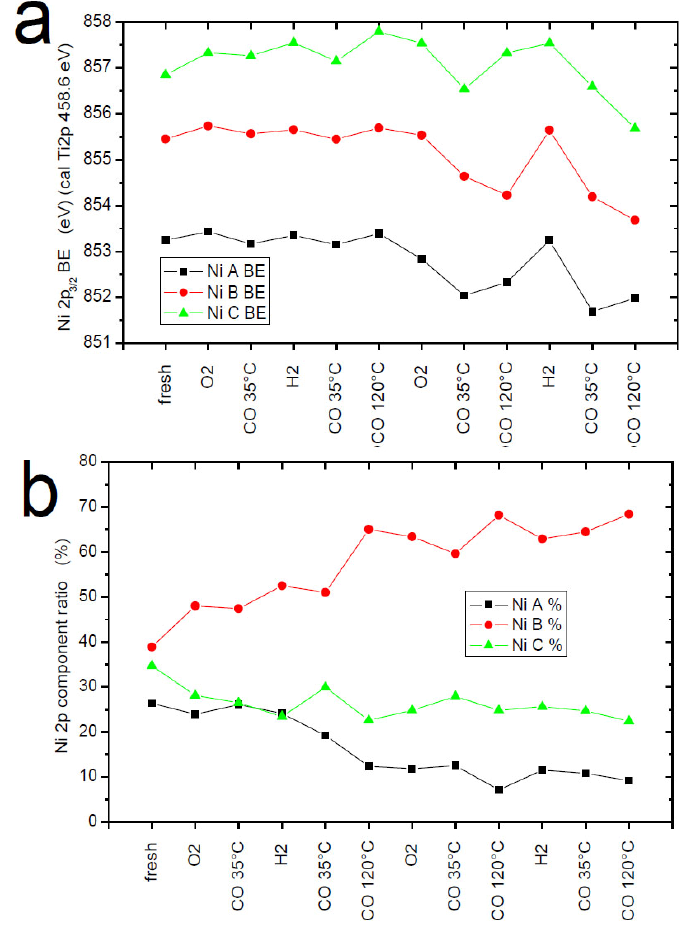
Figure 6. Ni 2p component line behaviour. A: Ni 2+ (NiO), B: Ni 3+ , C: Ni 2+ in salts or the interface ( a ) Binding energy changes; ( b ) Contents of various Ni species. Ni x+ -TiO 2